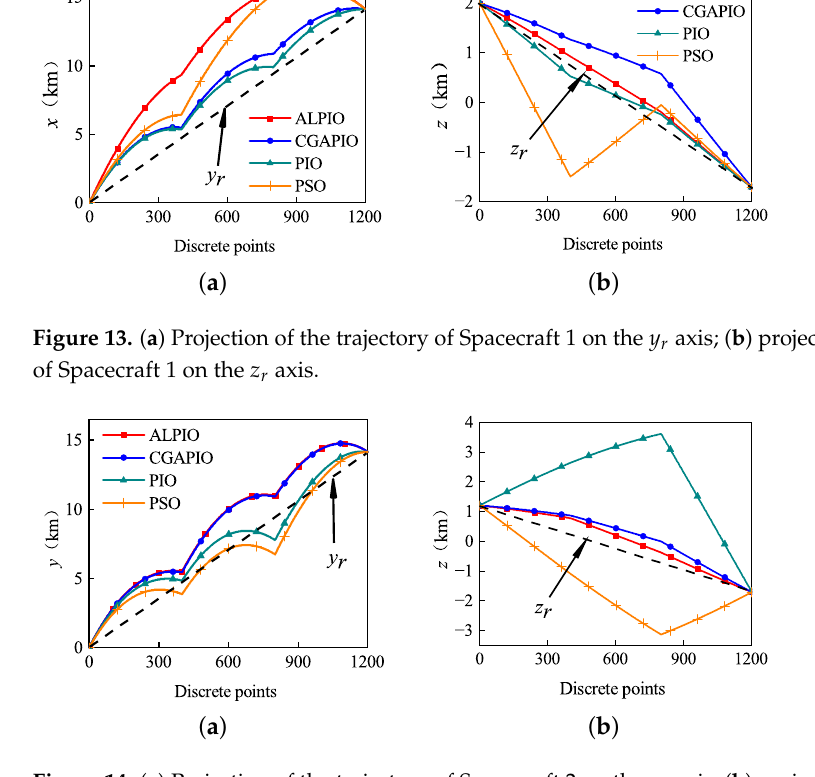
Figure 14. ( a ) Projection of the trajectory of Spacecraft 2 on the y r axis; ( b ) projection of the trajectory of Spacecraft 2 on the z r axis.